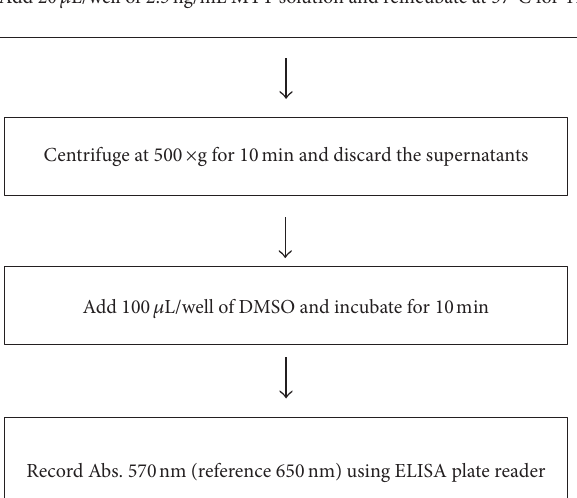
Figure 1: Flowchart of modified L929 cytotoxic bioassay system for TNF- 𝛼